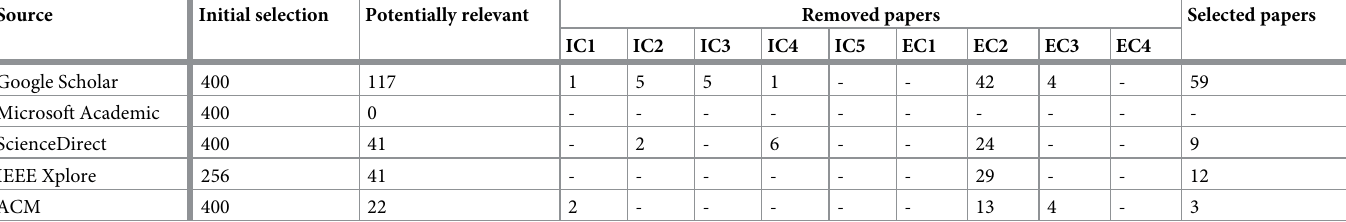
Table 3. Papers selection. The table shows the procedure through which potentially relevant papers were screened out through the adoption of IC and EC criteria. The number of papers included in the final reading log is shown in the column “Selected papers”. Source